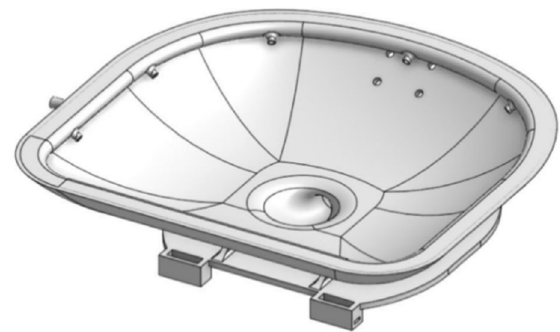
Fig. 5 Design of a basin—an isometric